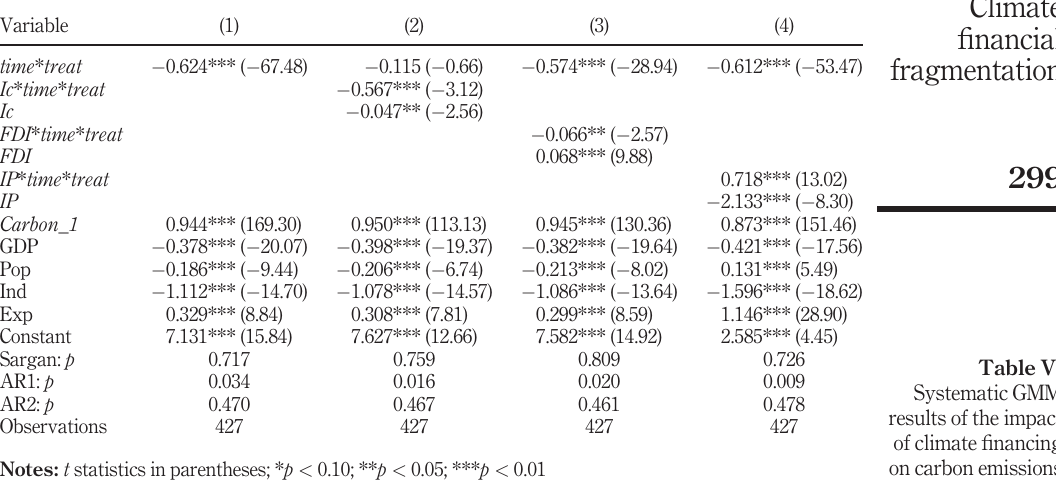
Table V. Systematic